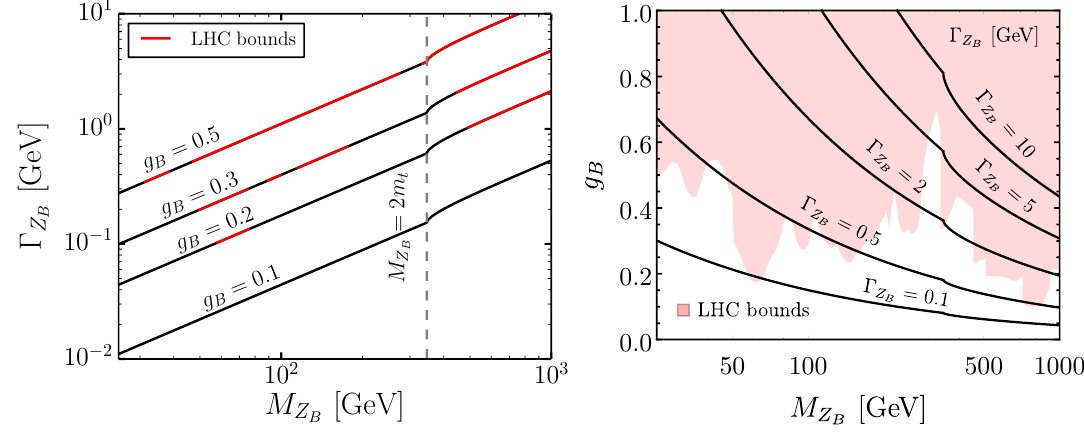
Figure 1 . Experimental bounds for the leptophobic gauge boson Z analyses (8 TeV and 18.8 fb (cid:0) 1 [20], 8 TeV and 19.7 fb (cid:0) 1 [21], 13 TeV and 35.9 fb (cid:0) 1 [19, 22] and 41.1 fb (cid:0) 1 [22], 13 TeV and 36 fb (cid:0) 1 & 27 fb (cid:0) 1 [23], 13 TeV and 18.3 fb (cid:0) 1 [24]), and ATLAS results (13 TeV and 3.6 fb (cid:0) 1 and 29.3 fb (cid:0) 1 [25]).